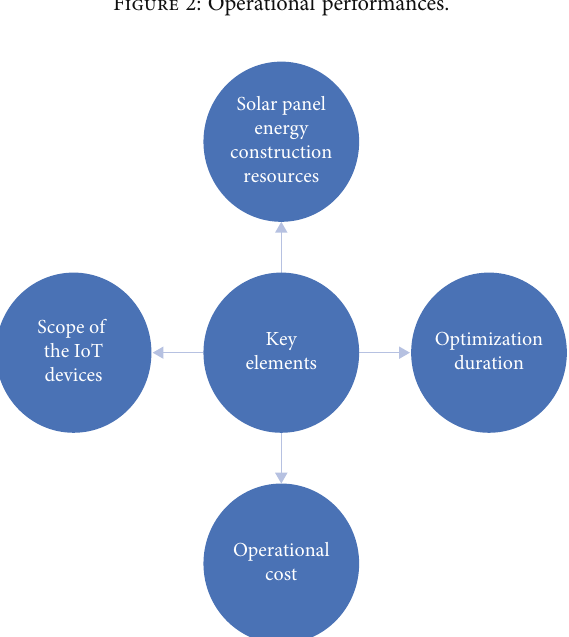
Figure 3: Key elements of energy units.